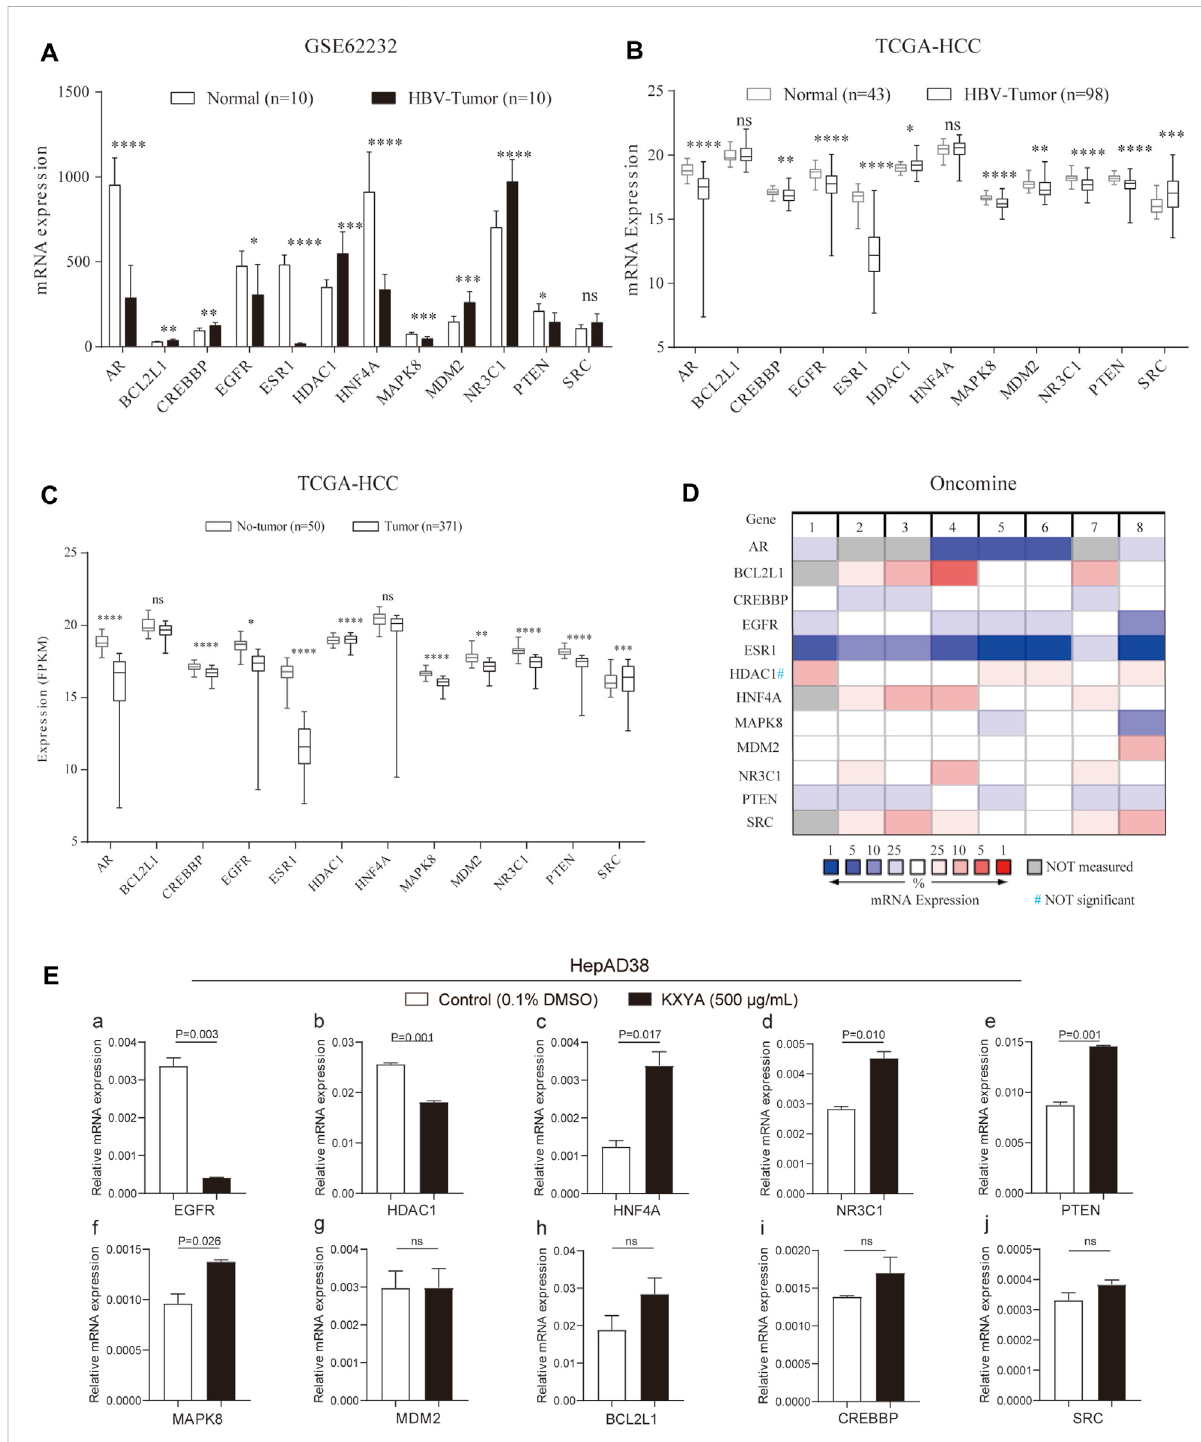
FIGURE 7 The mRNA expressionof the key genes in public databases and HepAD38cells with KXYA treatment. (A) The mRNA expressionof the key genes in GSE62232. (B) The mRNA expression of the key genes in HBV-related HCC of TCGA. (C) The mRNA expression of the key genes in HCC of TCGA. (D) The mRNA expression of the key genes in HCC of Oncomine. (E) HepAD38 cells was treated with KXYA (500 μ g/ml) for 48 h and the key genes ’ mRNA expression were detected by qRT-PCR, GAPDH was used as internal reference. Data are presented as the mean ± SD, p -value was calculated by performing un-pair Student ’ s t -test, ns, not signi fi